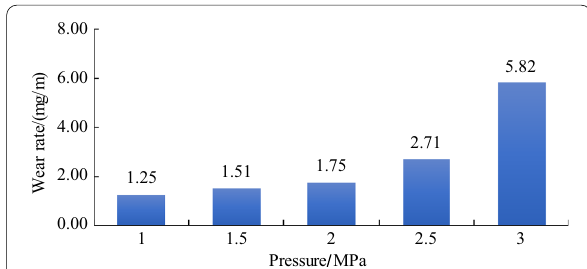
Figure 13 Effect of contact pressure on wear rate at